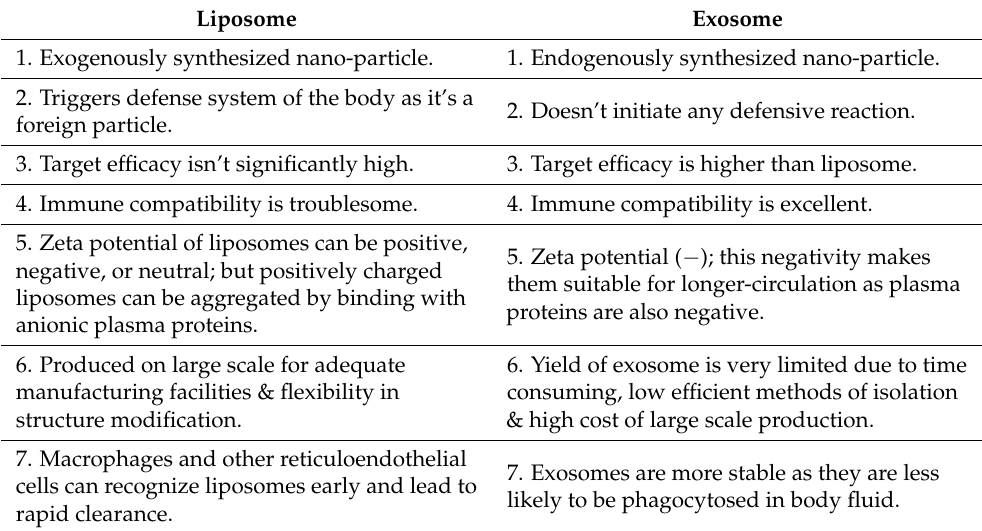
Table 3. Comparison between liposomes and exosomes as drug delivery vehicles.